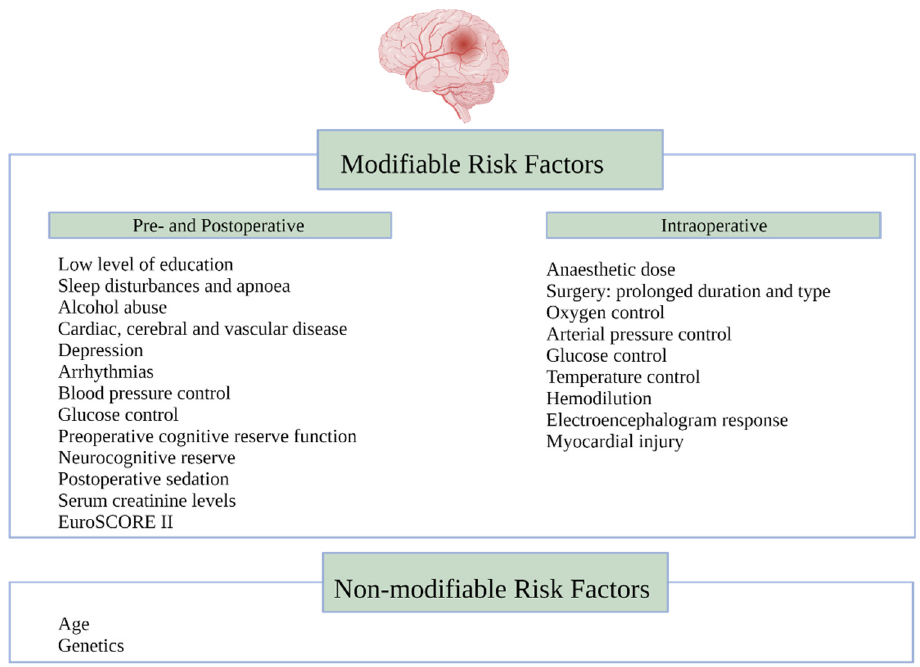
Figure 1. Risk factors for neuronal injury before, during and after cardiac surgery.